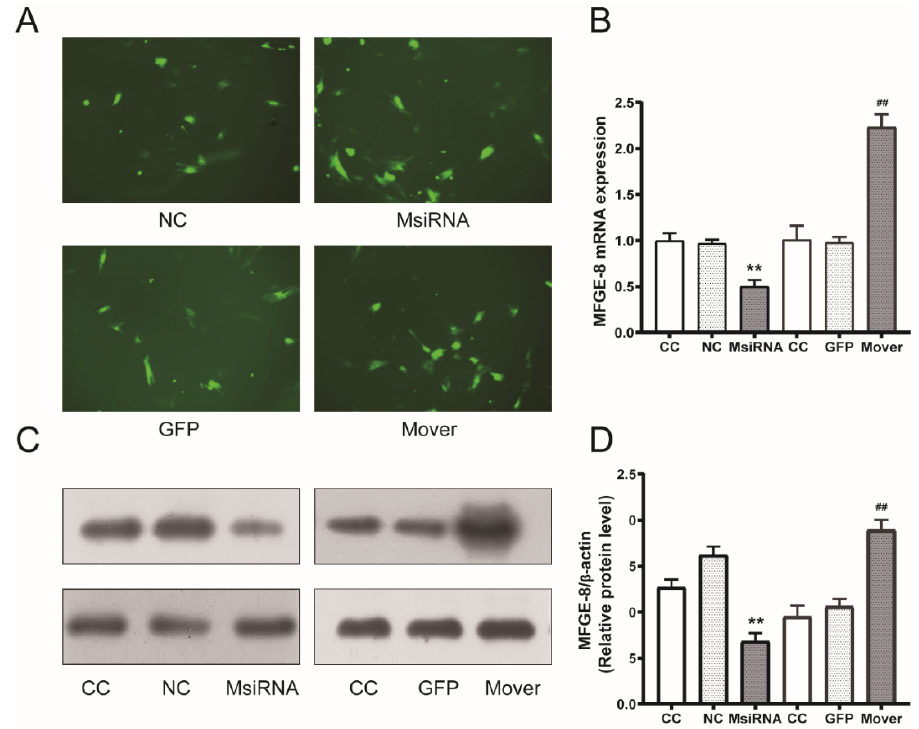
Figure 3. MFG-E8 small interfering RNA (siRNA) and overexpression plasmid transfection of